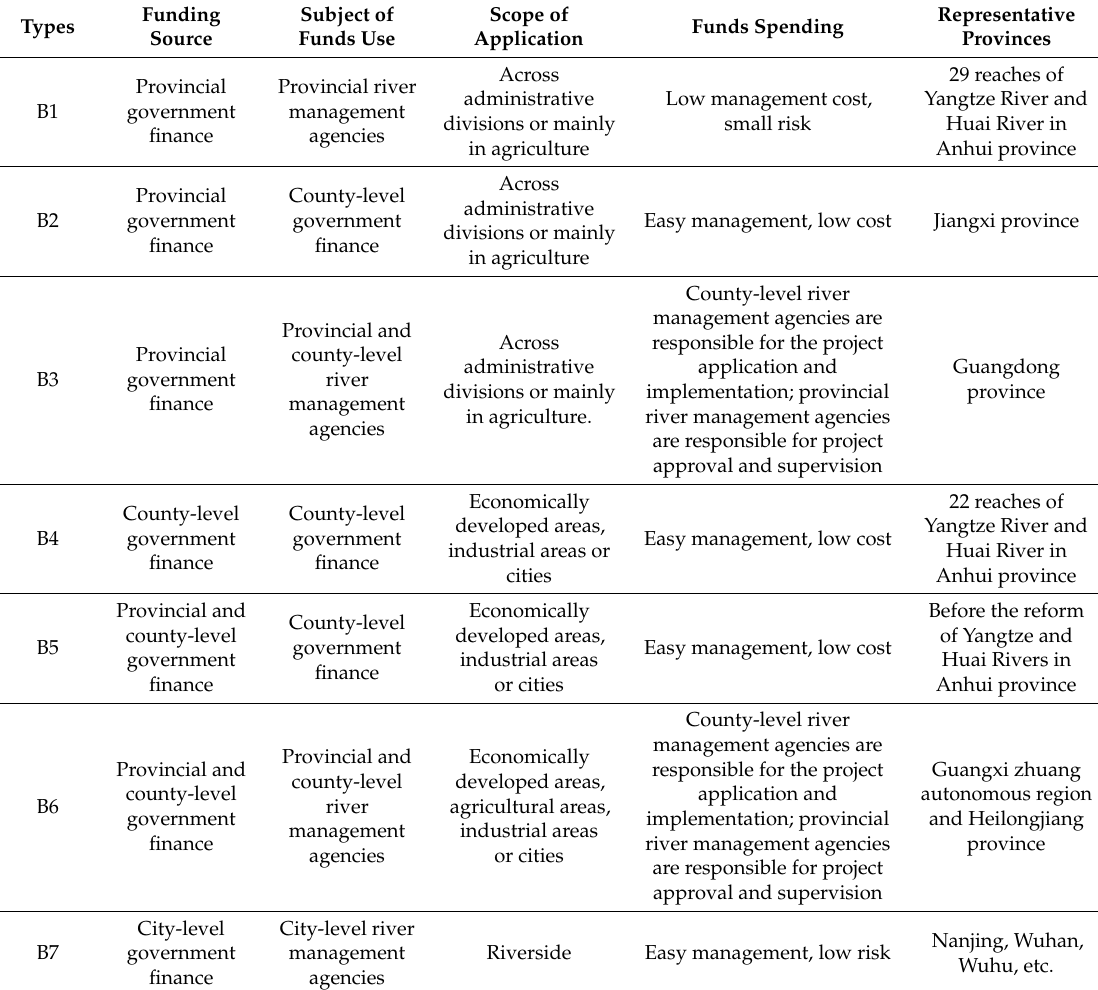
Table 2. Comparisons of bearing and use methods of the river maintenance fund.